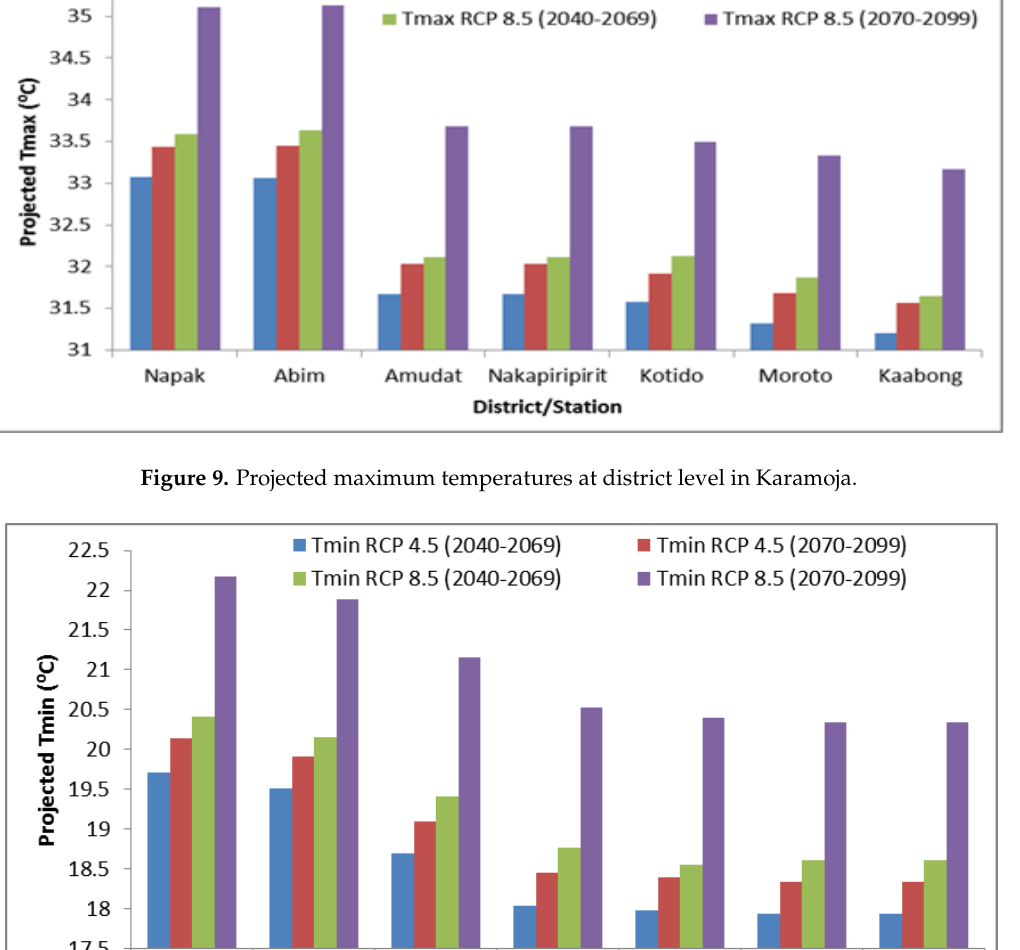
Table 6. Comparison of change in temperature from the baseline (1980–2009) period.